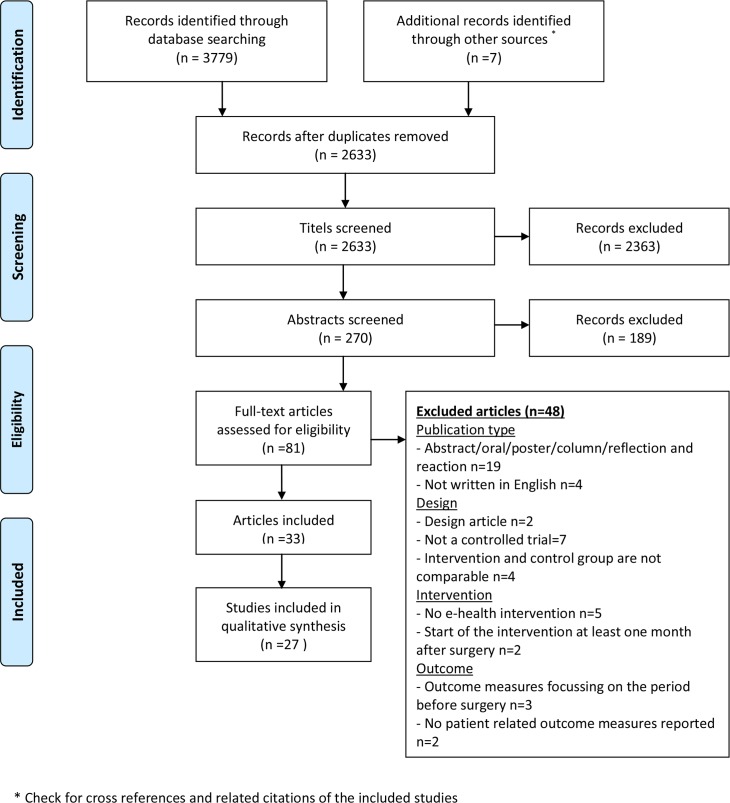
Prisma Flow diagram.